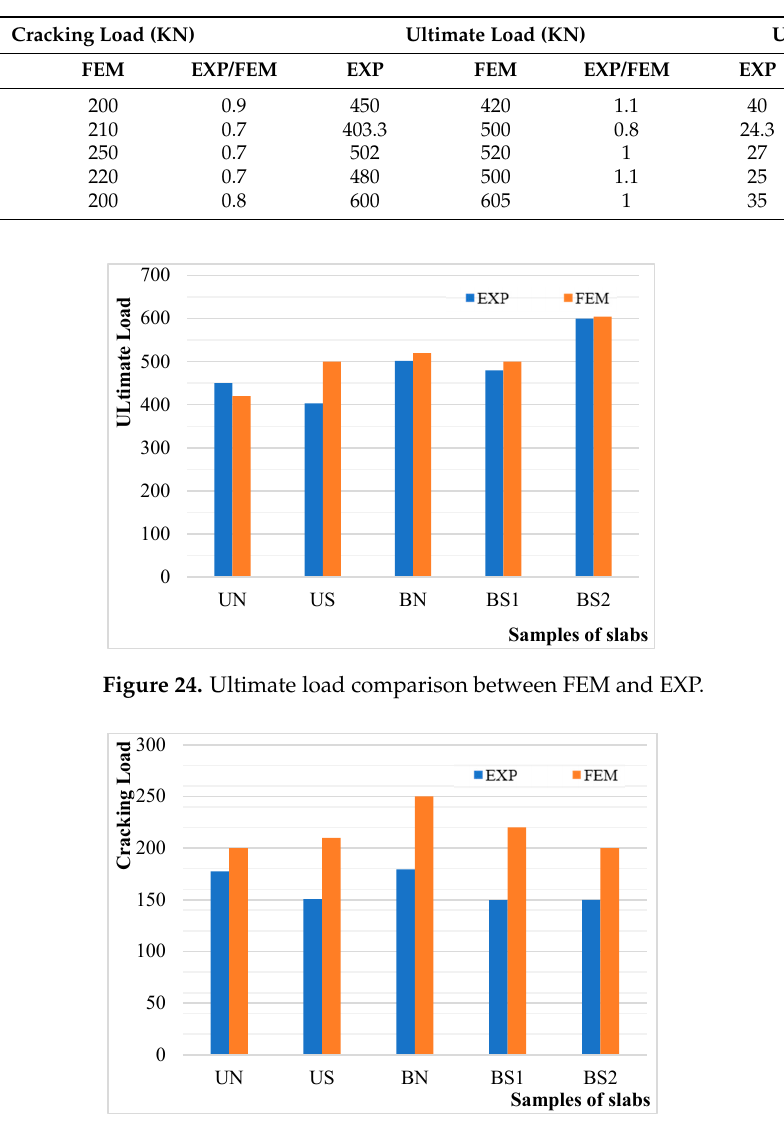
Figure 25. Cracking load comparison between FEM and EXP.